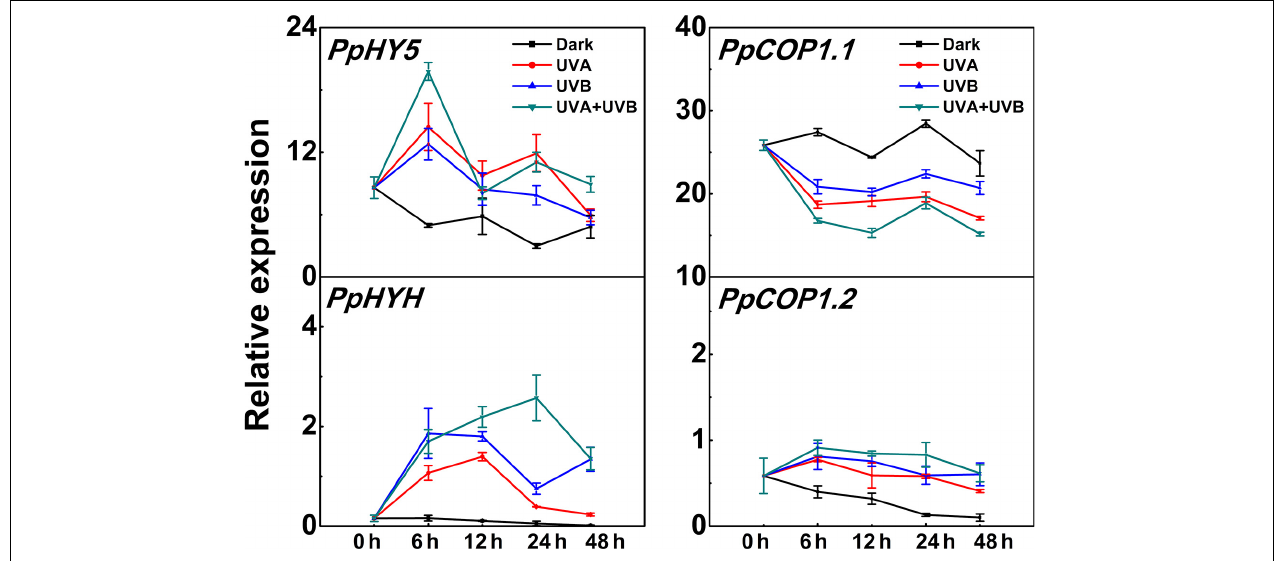
FIGURE 3 | Time course of the transcript levels of PpHY5 , PpHYH and PpCOP1.1 , PpCOP1.2 in peach peel in response to continuous UV lights. UVA, 1,000 µ w/cm 2 ; UVB, 58 µ w/cm 2 . Data were presented as means ( ± SE) from three independent biological